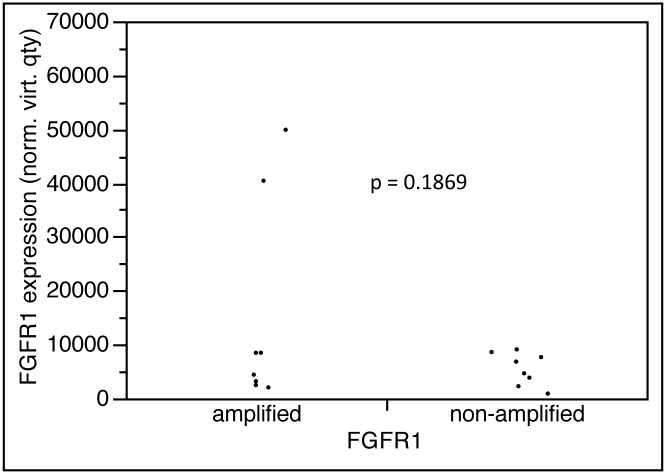
FGFR1 expression.